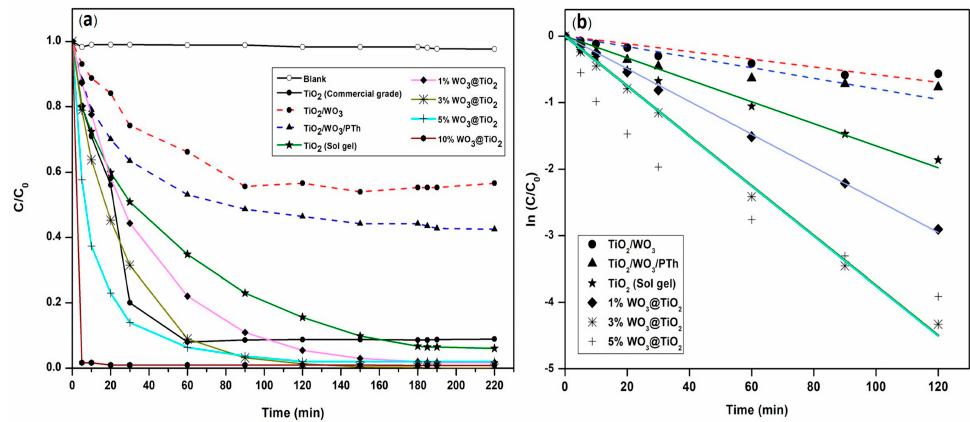
Figure 5. Photocatalytic degradation of MB in aqueous: ( a ) suspensions containing different types of composite metal oxides; ( b ) plot of ln C/C 0 vs. time.